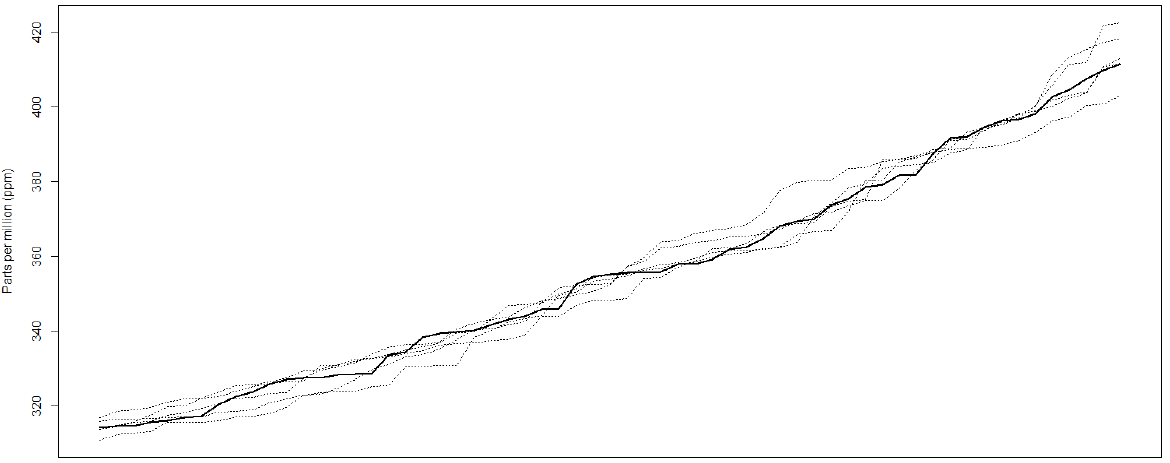
Figure 1. The annual average of CO 2 between 1959 and 2019 (solid), and five resamples (dotted). A general description of the maximum entropy bootstrap algorithm ([36,37]) for a random replicate of a time series is provided next: (1) the original data are sorted to create